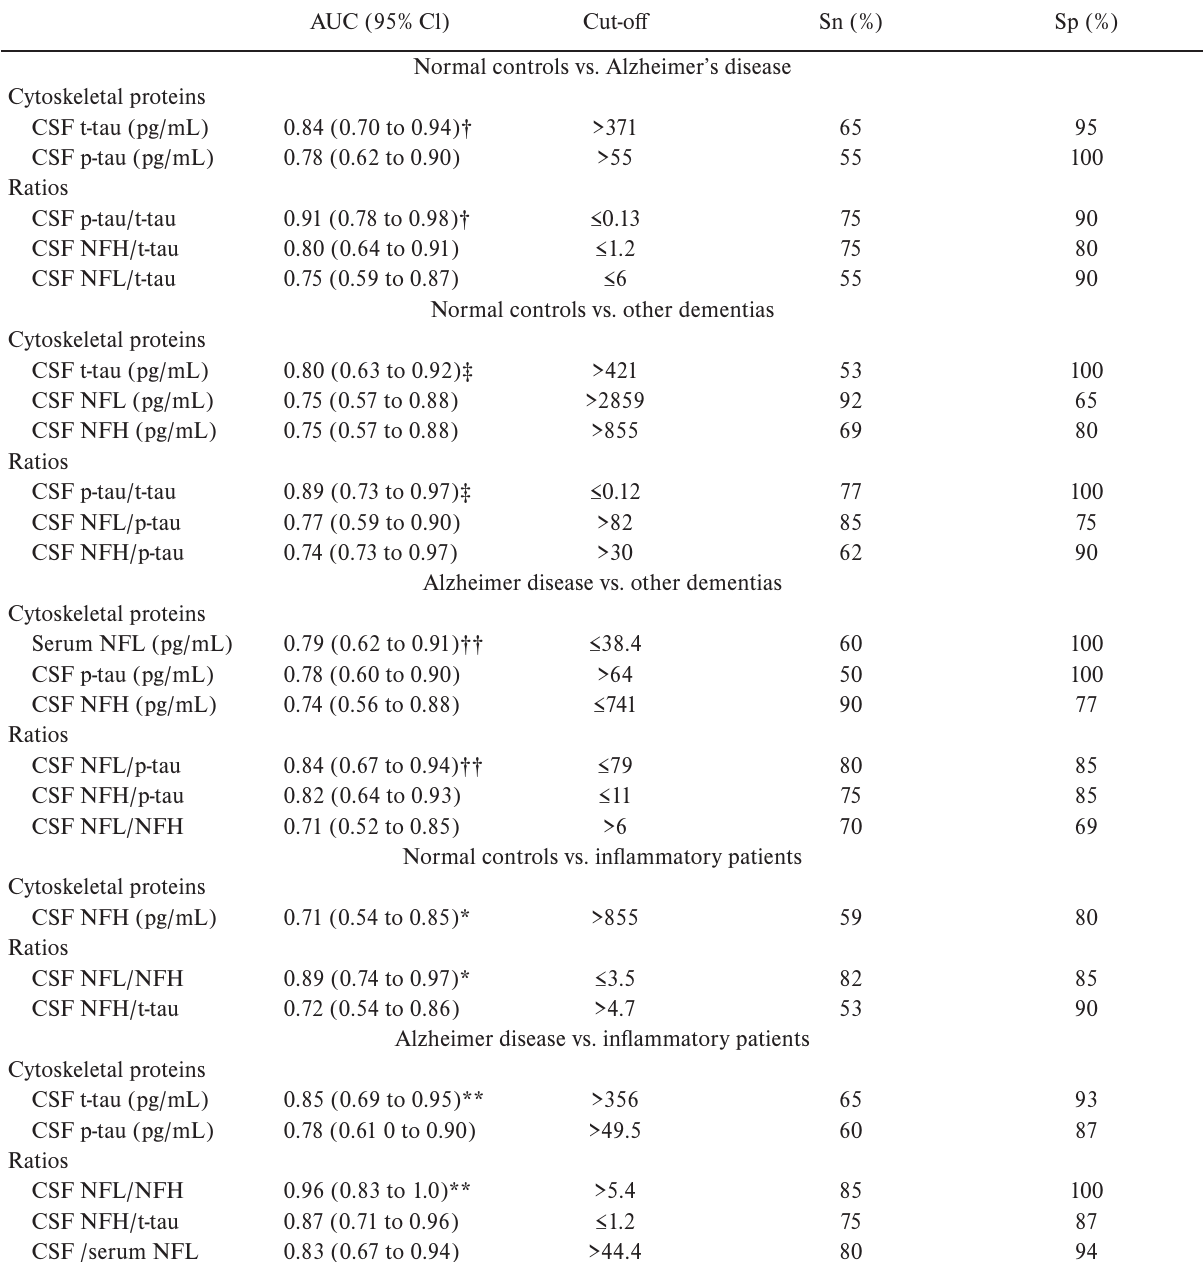
Table 2. Comparison of areas under the curve of receiver operating characteristics of neurocytoskeletal proteins and their ratios among patients’ groups. Cytoskeletal proteins and ratios with AUC > 0.70 are shown. AUC (95% Cl) Cut-off Sn (%) Sp (%) Normal controls vs. Alzheimer’s